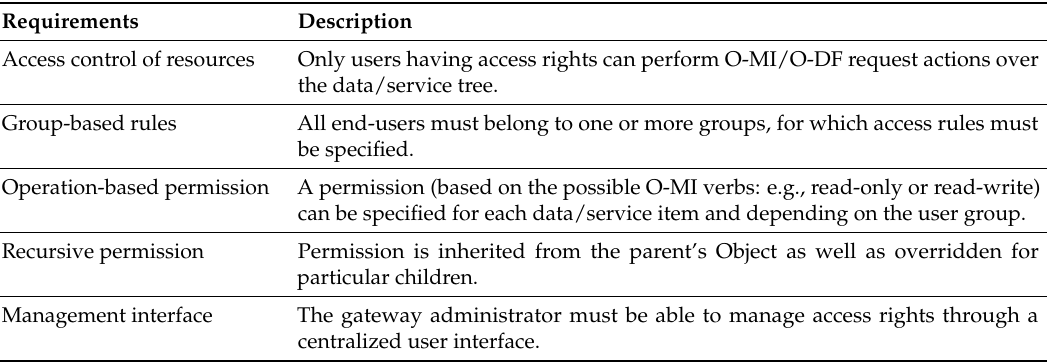
Table 1. Key requirements covered by the O-MI security and Micro-billing modules (Case 2 in Figure